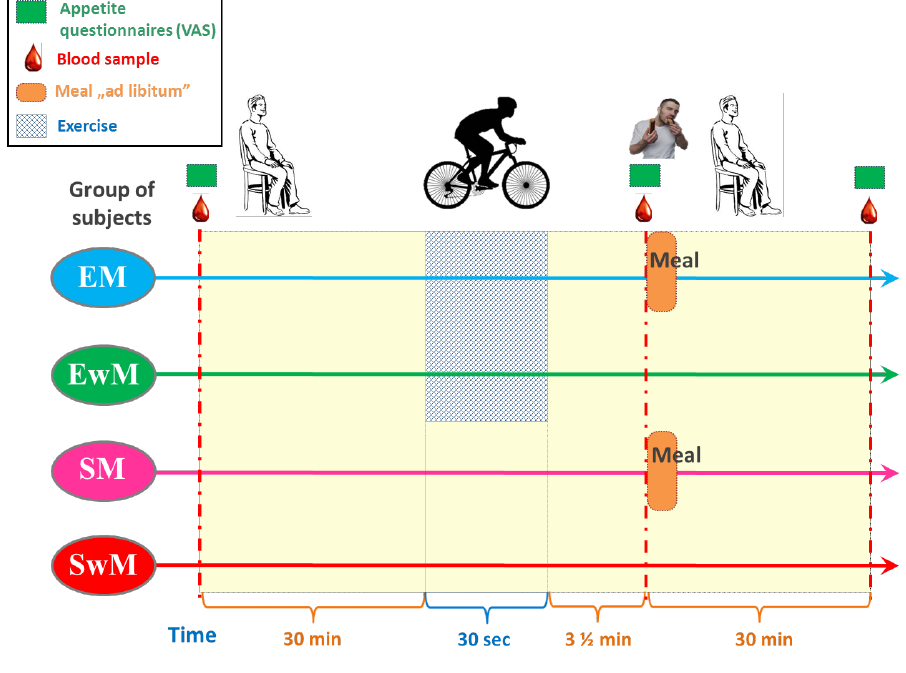
Figure 5. Schematic flowchart of the study design.